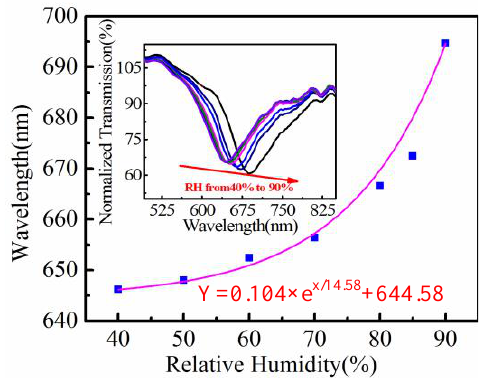
Figure 2. Resonant wavelength shift and spectrum evolution of a fiber SPR sensor with RH increasing. The initial wavelength is 645.52 nm, and the purple curve is an exponential fitting to the experimental data.